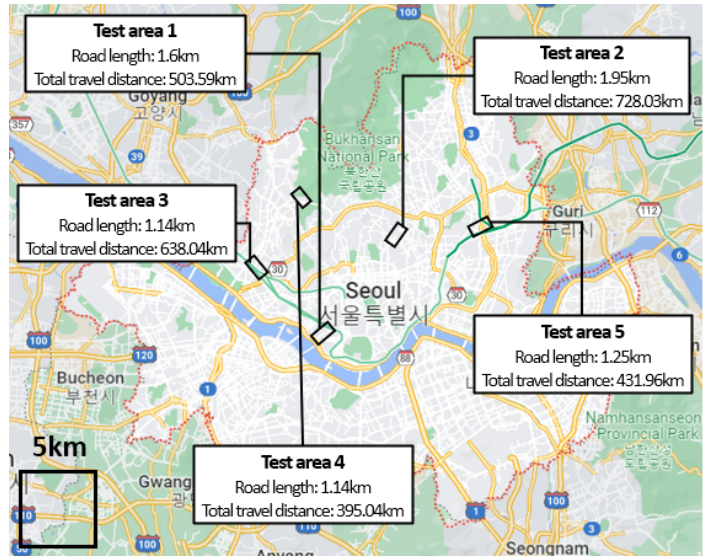
Figure 2. Quantitative information of the ROD collected from randomly sampled five test areas. Road length refers to the length of the road used for data collection in each test area. The total travel distance is the sum of the travel distances by multiple vehicles.